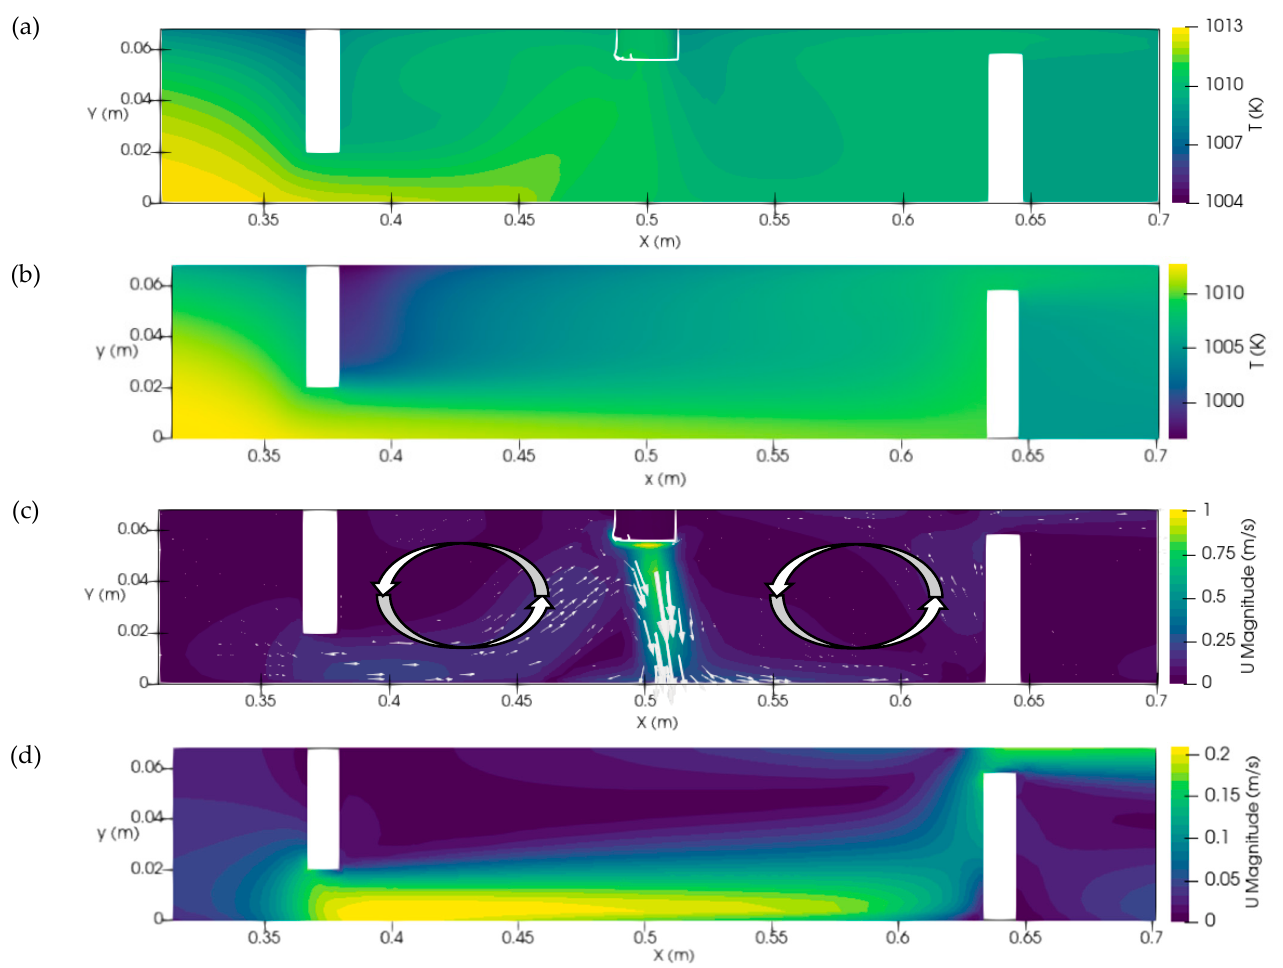
Figure 8. Temperature distribution when UST was applied ( a ), and without UST ( b ). Velocity fields when UST was applied ( c ), and without UST ( d ). Note the different velocity scales in ( c ) and ( d ). Flow from left to right.